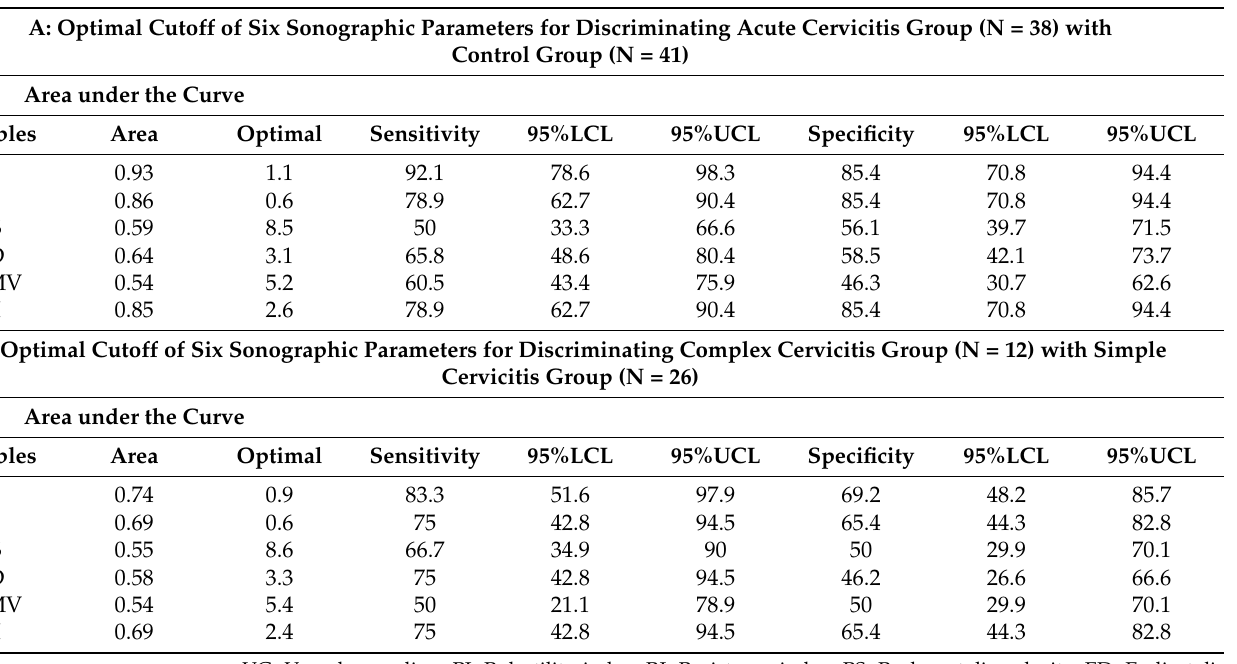
Table 3. Optimal cutoff values of six sonographic parameters for discriminating between the case group ( n = 38) and control group ( n = 41). It is also between complex cervicitis group (N = 12) with simple cervicitis group (N =